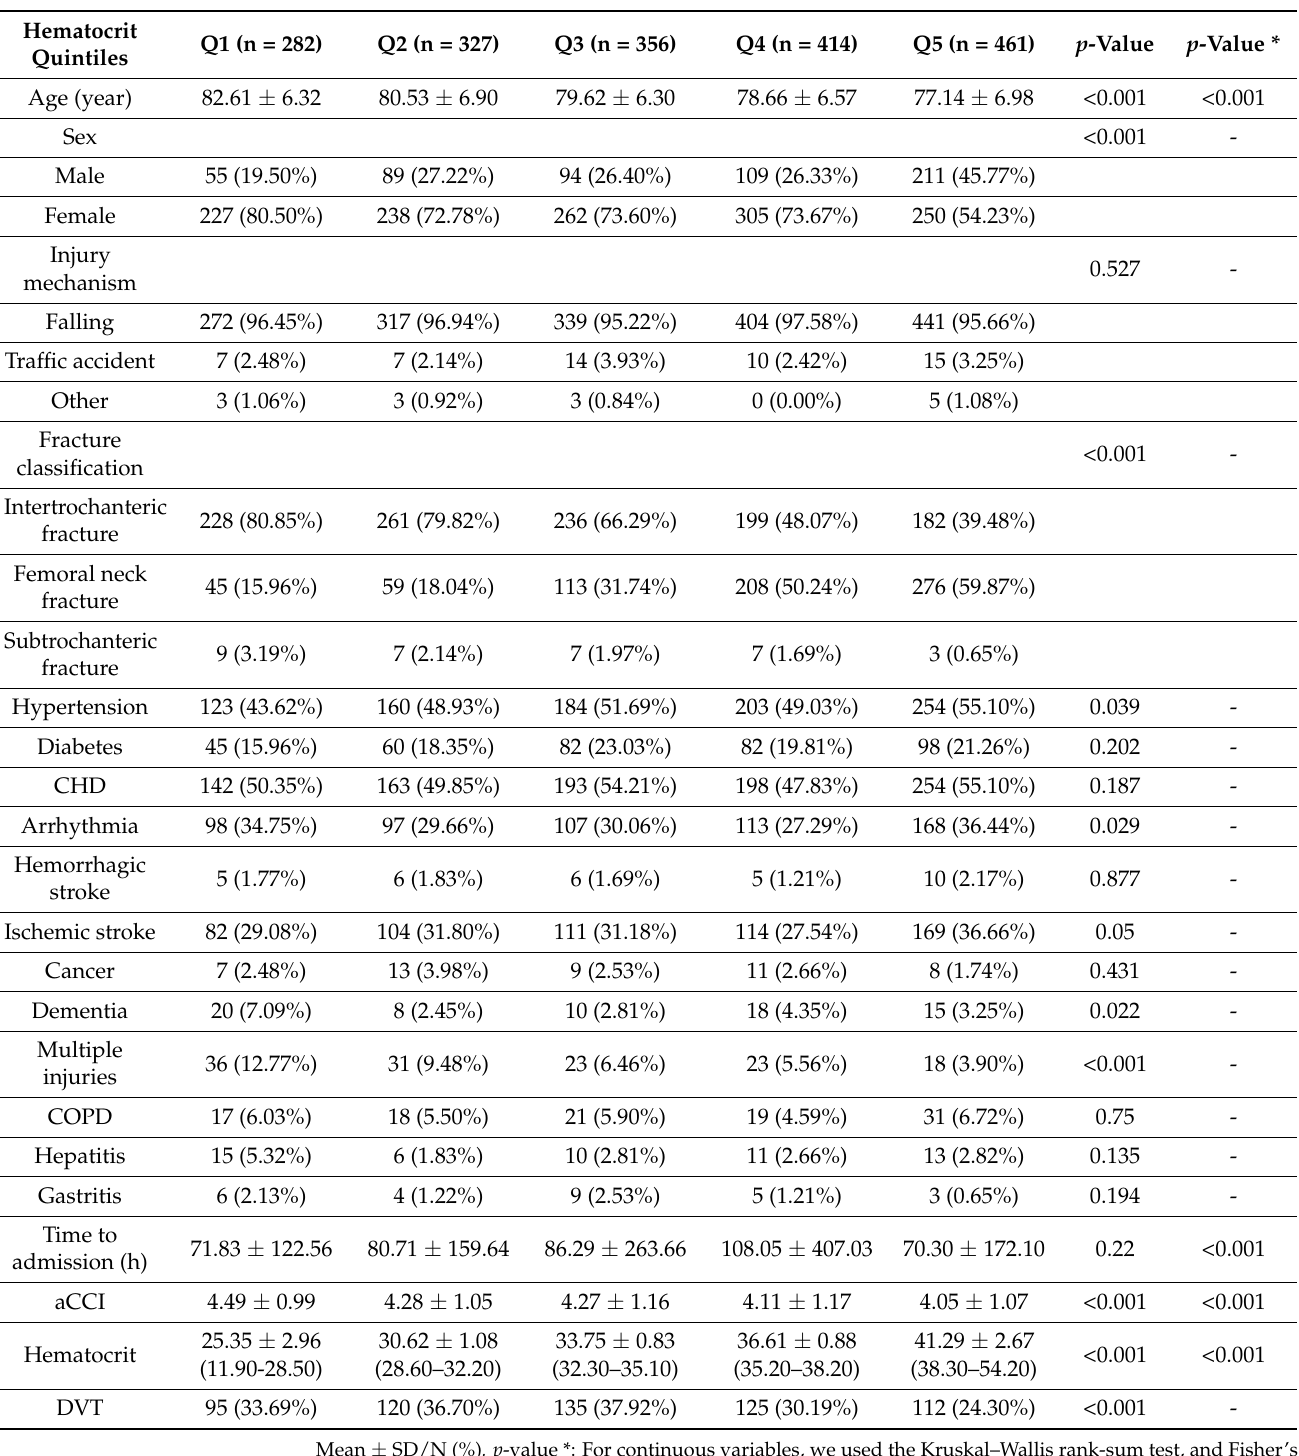
Table 1. The demographic and clinical characteristics of the patients (N =